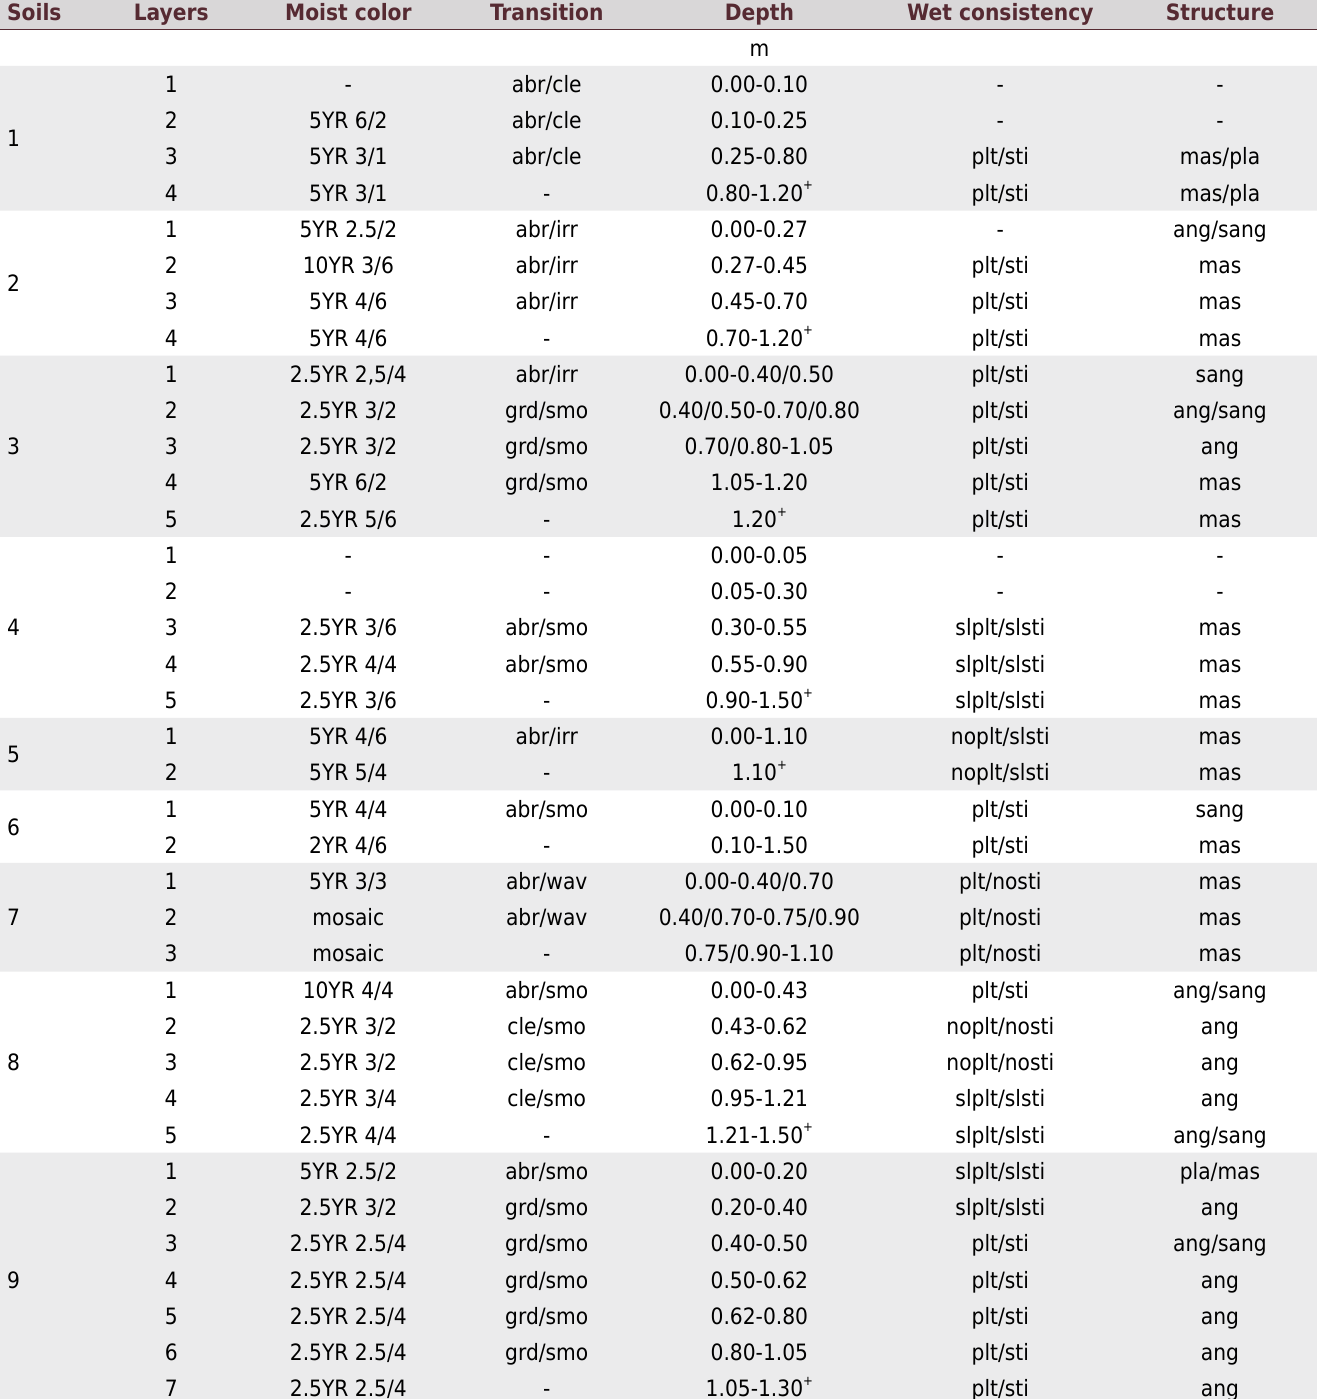
Table 3. Morphology of urban soil profiles in Santa Maria, Rio Grande do Sul State, Brazil Soils